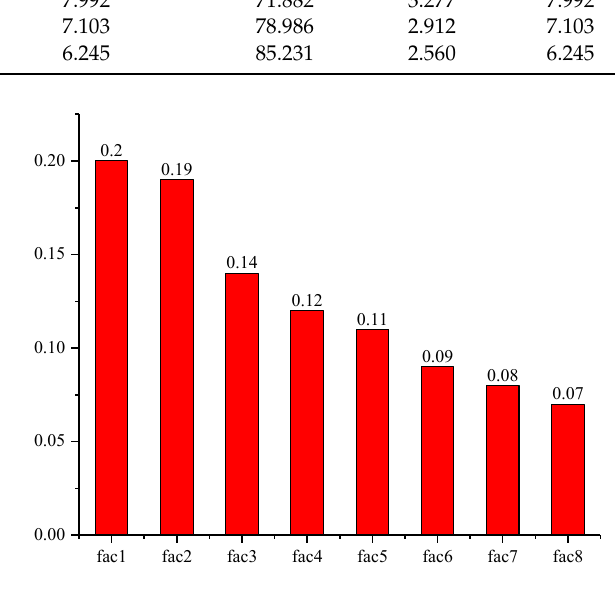
Figure 3. Factor weight distribution.